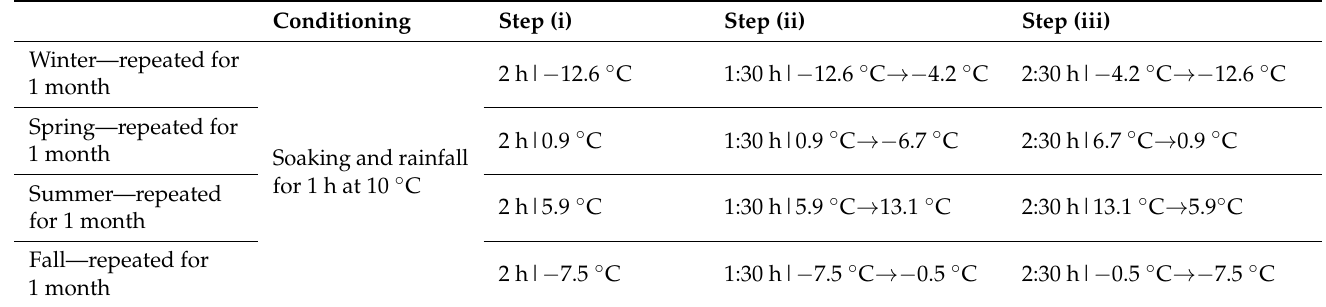
Table 2. Detailed description of the selected temperatures and steps for each season simulation in the climatic chamber ARALAB FITOCLIMA